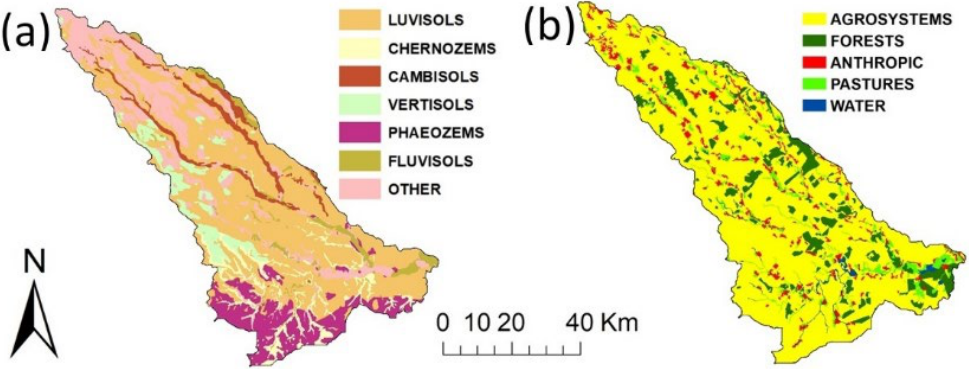
Figure 2. Spatial distribution of soil ( a ) and land use ( b ) types in the Neajlov River